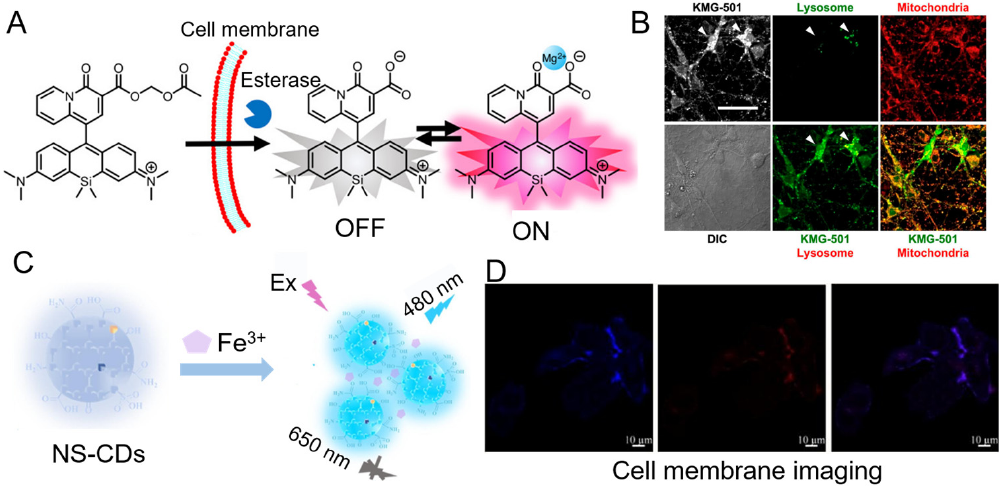
Figure 7. Two representative examples of essential metal ion detection in living cells: ( A ) Schematic illustration of the intracellular imaging of Mg 2+ via KMG-500 series probes. ( B ) Intracellular localization of KMG-501 in the whole cell body of cultured hippocampal neurons. Reproduced from [121] with permission from the American Chemical Society, copyright 2020. ( C ) Schematic illustration of NS-CDs for the ratiometric response to Fe 3+ and cell membrane imaging. ( D ) NS-CDs for targeted cell membrane imaging. Reproduced from [128] with permission from Elsevier, copyright 2021.